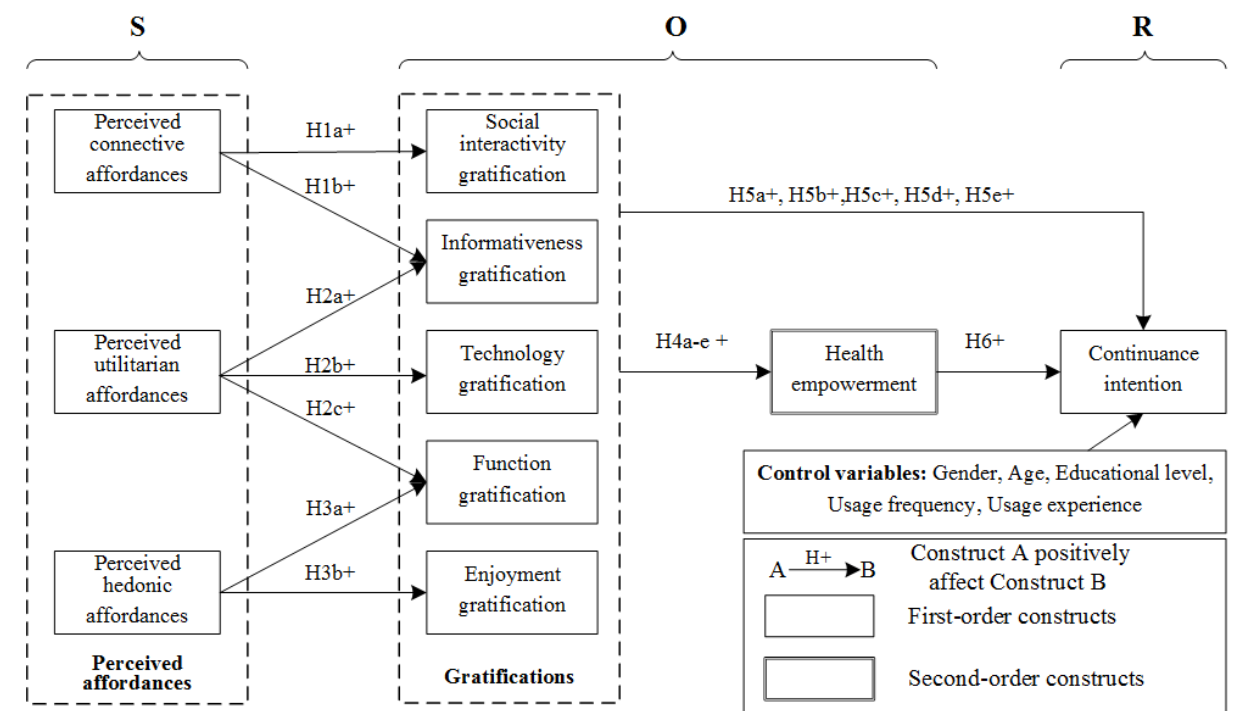
Figure 1. Research